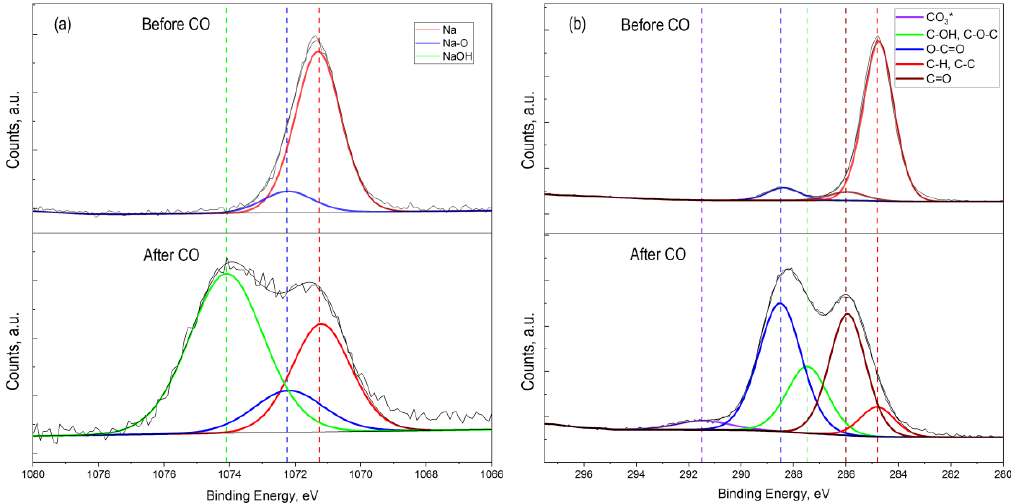
Figure 6 Figure 6. High-resolution XPS spectrum of Zn 2p ( a ), Sn 2p ( b ), and O 1s ( c ) for ZTO film with Zn:Sn ratio 99:1 before and after CO treatment at T = 300 ◦ C.